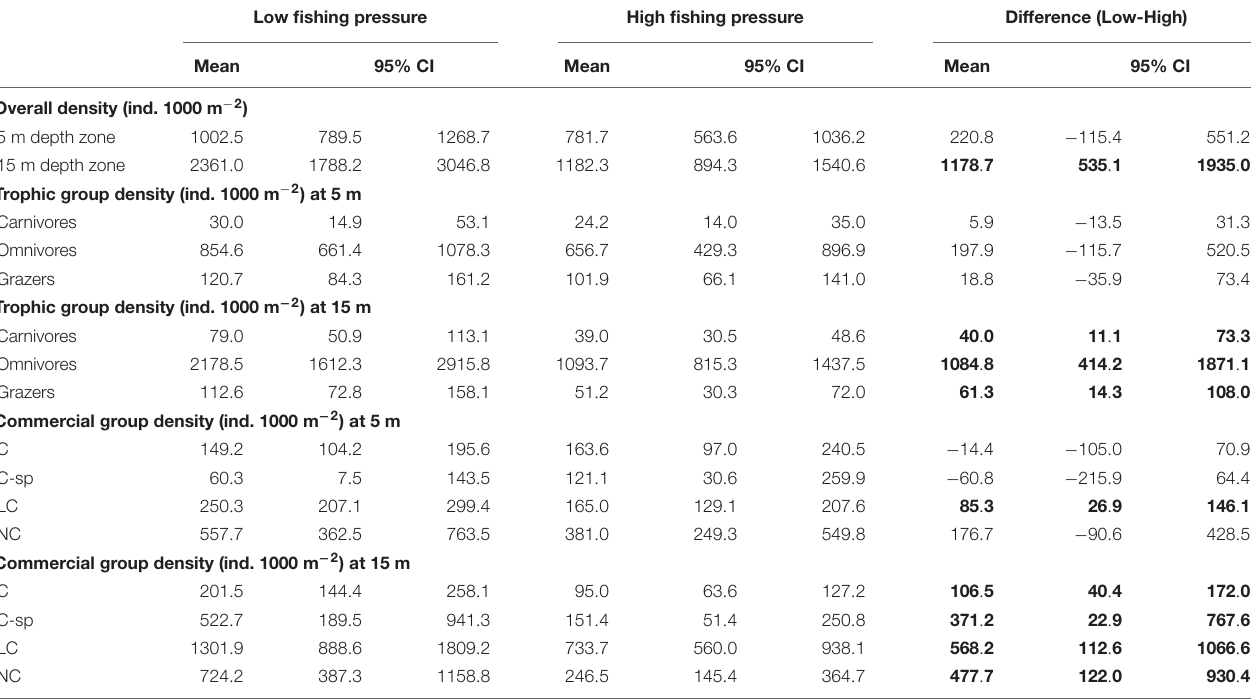
TABLE 3 | Mean density values (ind. 1000 m − 2 ), along with the 95% confidence intervals (CI), of fish species for low and high fishing pressure sites of the Aegean Sea and for the difference between them (Low-High). Low fishing pressure High fishing pressure Difference (Low-High) Mean 95% CI